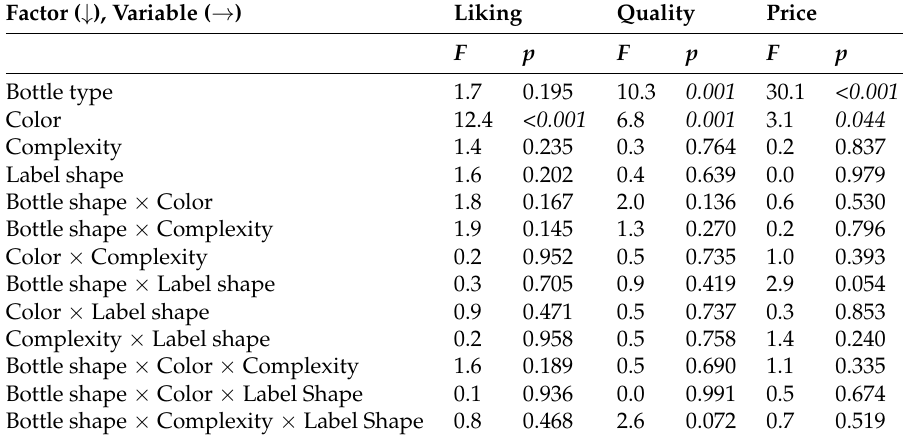
Table 2. ANOVA tables reporting test statistics and p -values associated with all main effects and interactions on the three dependent variable Liking, Expected quality, Expected price.